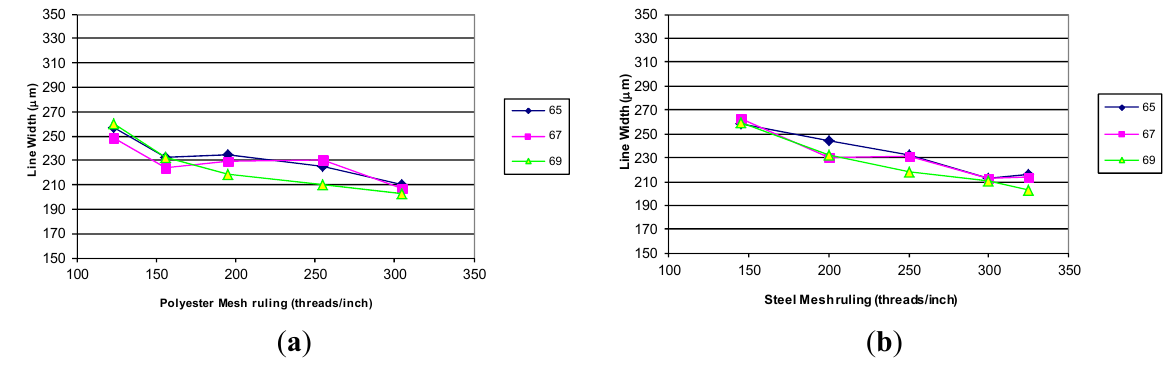
Figure 7. The effect of mesh ruling on the cured line width of the paste inks for a nominally 200 μ m line ( a ) polyester and ( b ) stainless steel